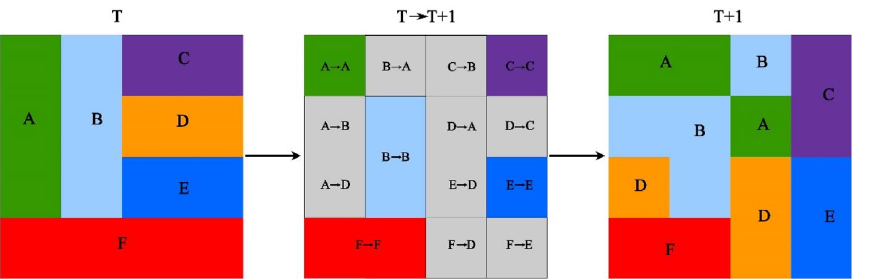
Figure 3. Land use transfer process. T the beginning of land use types, T + 1 the end of land use types; A, B, C, D, E, F: different land use